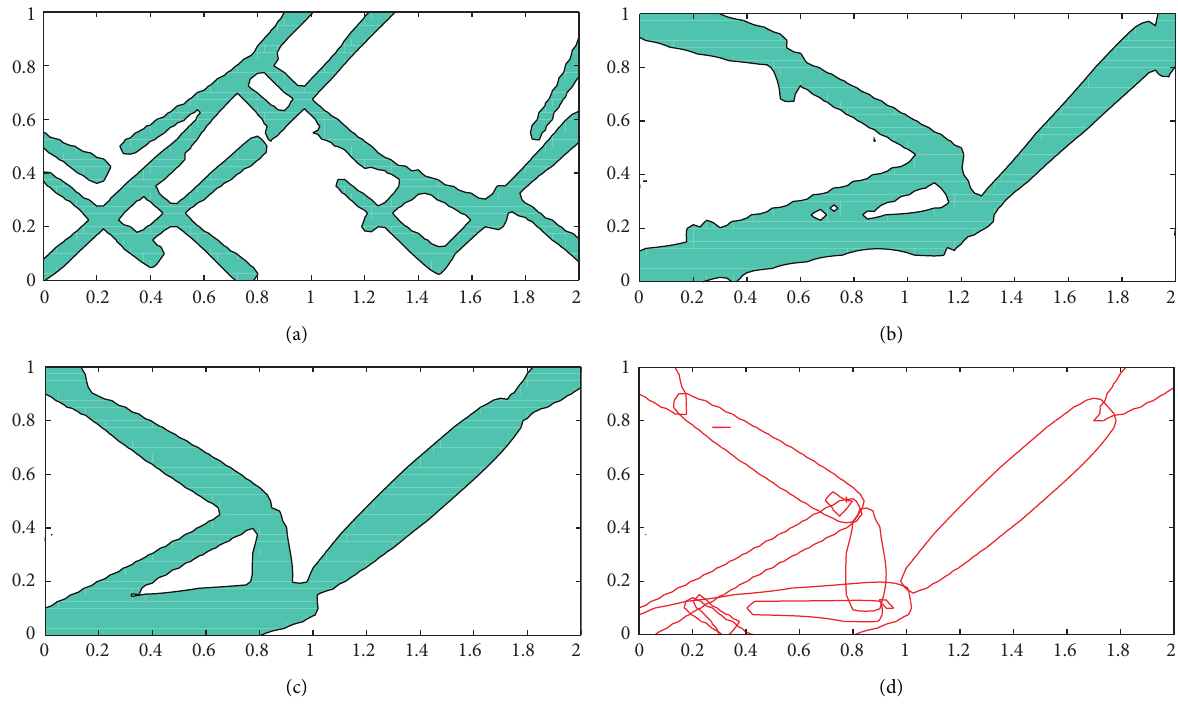
Figure 9: Some intermediate optimization results and the final results of the compliant mechanism example with the QVT